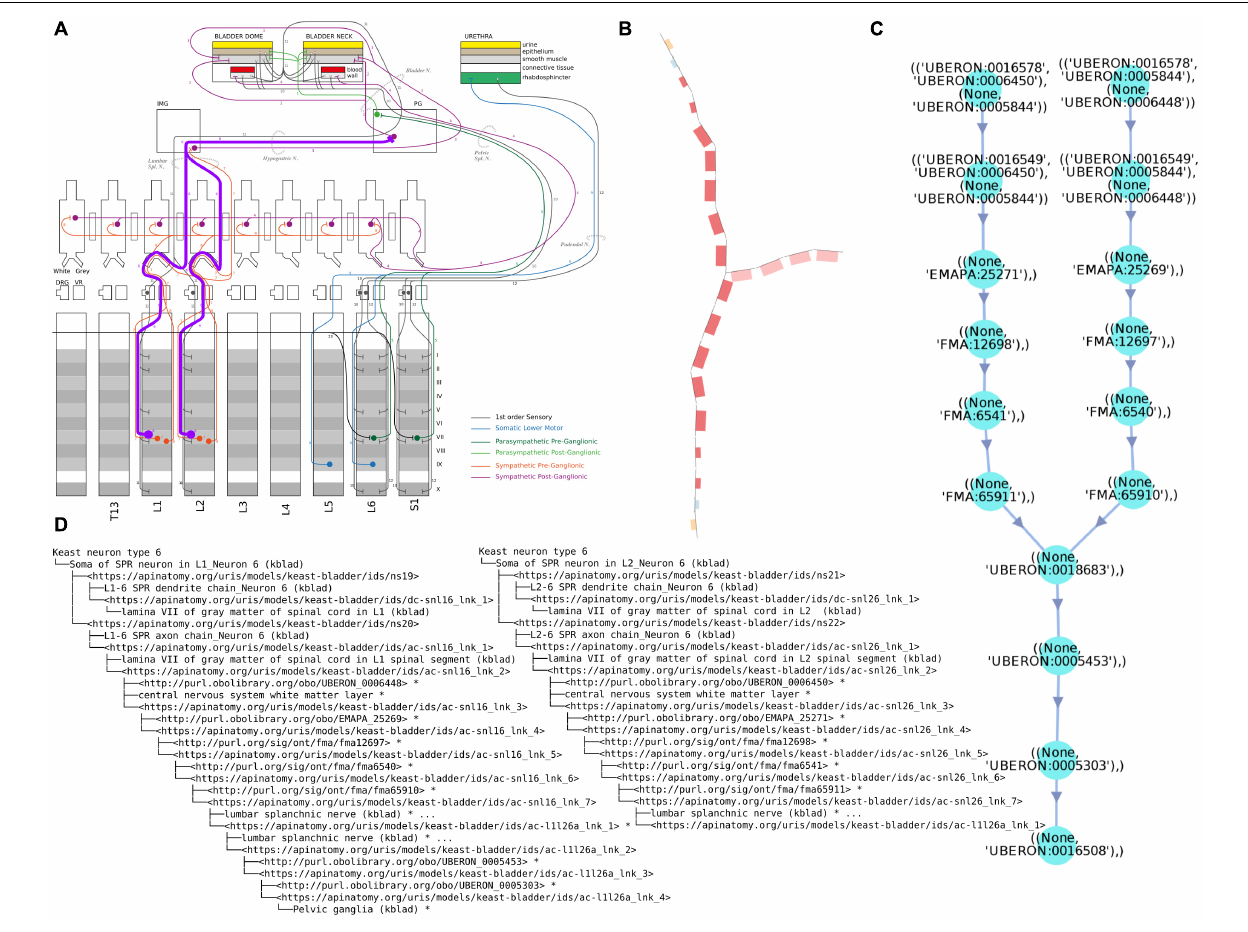
FIGURE 2(ii) | Examples of different renderings of a typical ApiNATOMY query output, in this case for the parts of a neuron population and their locations. All the queries employed here are maintained in Gillespie (2021h). (A) “Keast” neuron type 6 (NTK6) highlighted on the original hand drawn diagram. (B) NTK6 rendered in the ApiNATOMY viewer. (C) SciGraph query results (raw format is JSON, see Supplementary Material ) for NTK6 condensed and rendered via CytoScape. (D) SciGraph query results for NTK6 rendered as a